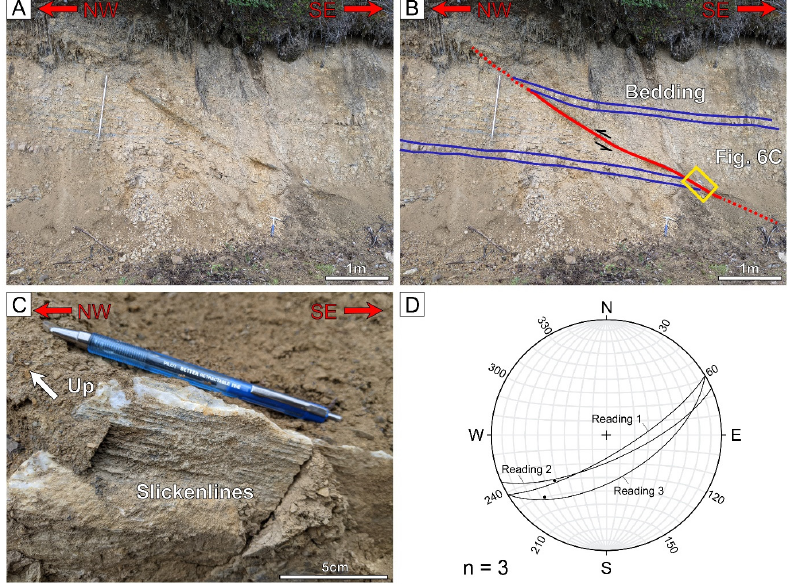
Figure 6. A NE–SW-striking, SE-dipping oblique (sinistral) reverse fault with >1 m apparent vertical offset cutting through conglomerates, which possibly belongs to the Upper Cretaceous Carmacks Group (uKC1), along the Sixtymile road. ( A ) Uninterpreted outcrop photo. ( B ) Interpreted outcrop photo. ( C ) A blown-up image of the slickensided fault plane. The location of this image is indicated by the yellow box in ( B ). Refer to Figure 2 for location. ( D ) Stereographic projections of fault planes and lineations of the oblique reverse fault along the Sixtymile Road. Structural readings for this oblique reverse fault are listed in Table 1 as “R1, R2”. Table 1. Fault structural measurements. Minerals 2022 , 12 , x FOR PEER REVIEW